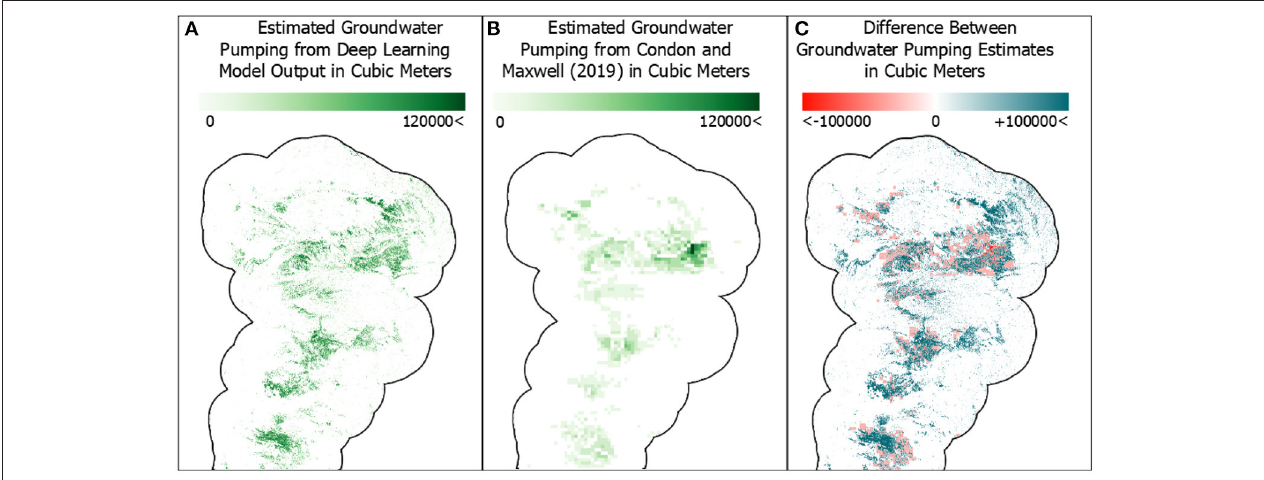
FIGURE 6 | Comparison of groundwater pumping estimates in the Ogallala Aquifer. The maps in all panels are in 1 × 1km resolution which involved resampling the underlying data from 30 × 30m resolution for the deep learning model’s output and 11 × 11km resolution for the Condon and Maxwell (2019) data. The map in (C) shows where the estimates in (A) are less than the estimates in (B) in red while the areas marked in blue show where the estimates in (A) are greater than the estimates in (B) . Areas with a high concentration of CPIS along with the surrounding land show the most remarkable differences between the two